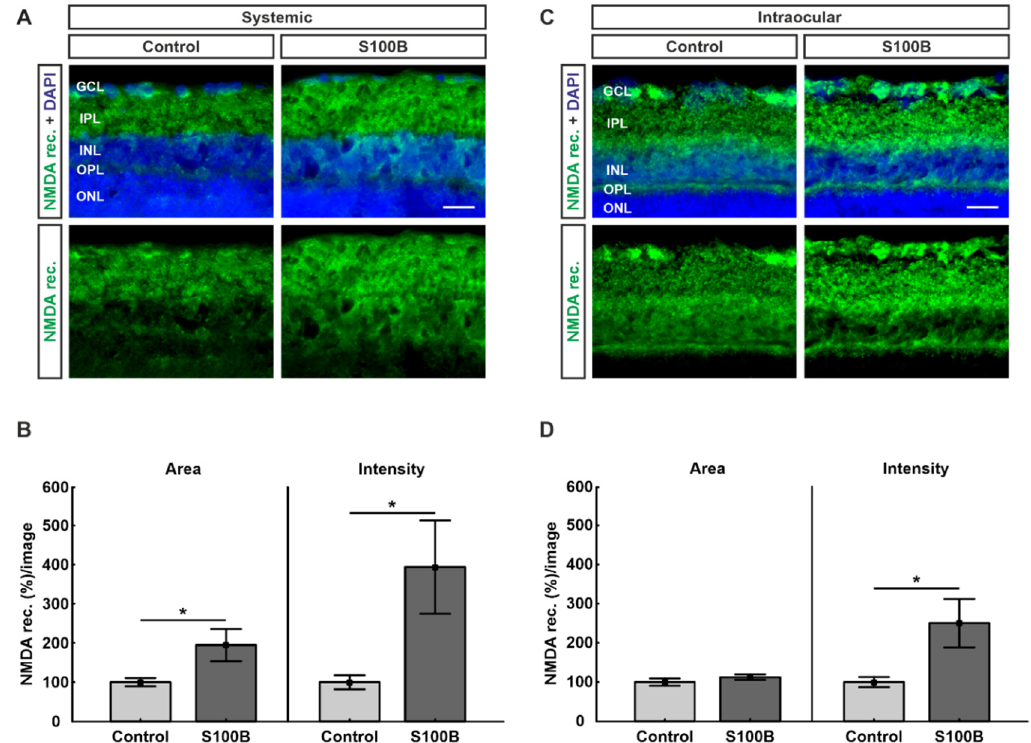
Figure 4. Upregulation of NMDA receptors. ( A ) Retinas from systemically immunized animals ( n = 7 / group) were stained with antibodies against NMDA receptors (green). Cell nuclei were visualized with DAPI (blue). ( B ) In comparison to controls, the NMDA receptor signal area ( p = 0.04) as well as the intensity ( p = 0.03) of the staining were significantly increased in the S100B group. ( C ) Retinas from the intraocular injection study ( n = 6–7 / group) were labeled against NMDA receptors (green). Cell nuclei were stained with DAPI (blue). ( D ) Statistical analyses showed that there was significantly higher staining intensity in the S100B group in comparison to controls ( p = 0.03). The percentage of labeled area was very similar in both groups ( p = 0.29). Abbreviations: GCL: ganglion cell layer; IPL: inner plexiform layer; INL: inner nuclear layer; OPL: outer plexiform layer; ONL: outer nuclear layer; NMDA rec.: NMDA receptor. Scale bars: 20 µ m. Values are mean ± SEM. * p <